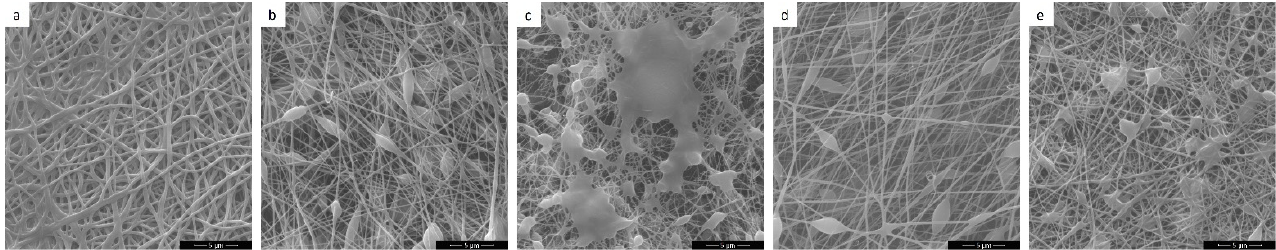
Figure 1. Original SEM images ( a ) pristine PUR; ( b ) PUR/TETA (1 wt.%); ( c ) PUR/TETA (5 wt.%); ( d ) PUR/TEPA (1 wt.%); ( e ) PUR/TEPA (5 wt.%). Table 1. Average values of the nanofiber diameters (in nm) obtained in the MMD measurements and air permeability for the pristine PUR membrane and the TETA- and TEPA-modified amine membranes (1 and 5 wt.%) and the CO 2 sorption capacity in g/cm 3 (third column).